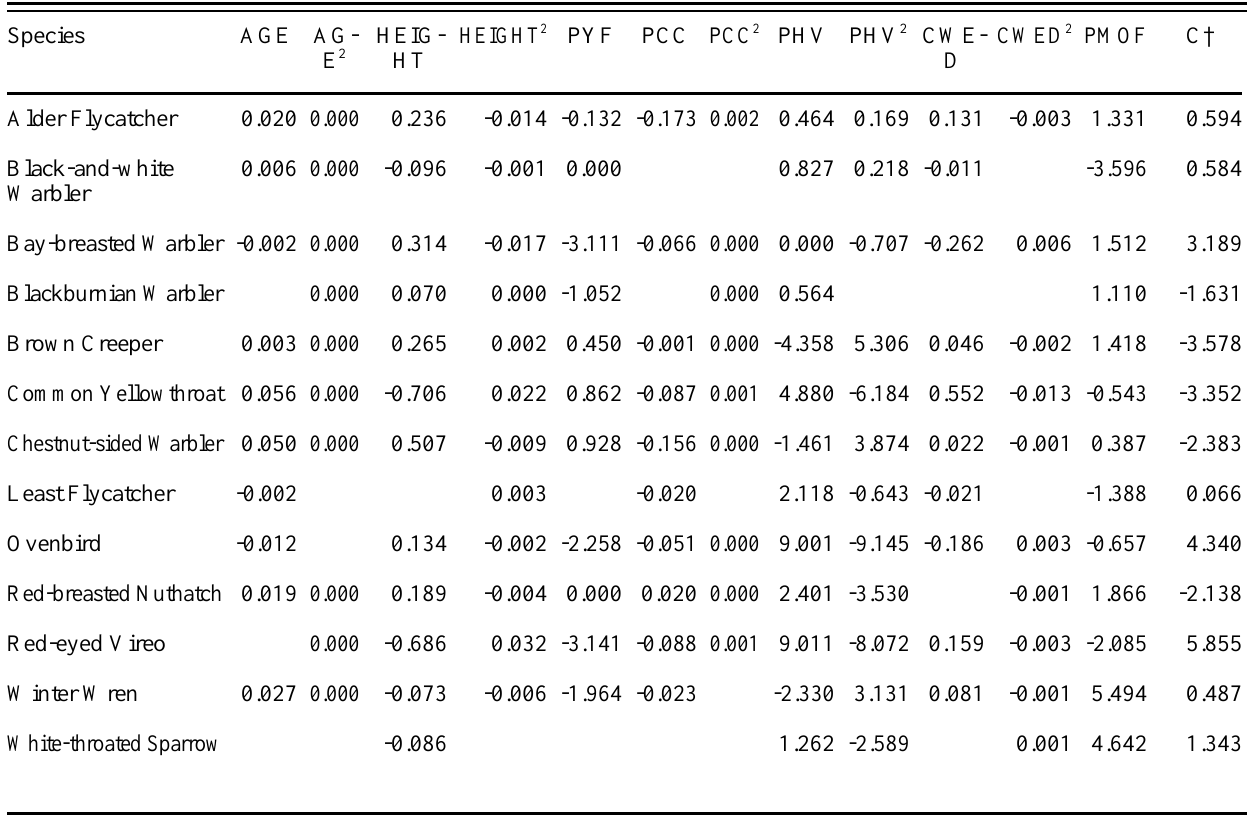
Table 7. Model coefficients and constant (C) for logistic regressions, where additive sum is probability of habitat